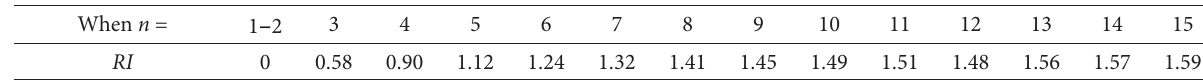
Table 4. Random index values for different matrix orders (Coyle 2004) When n